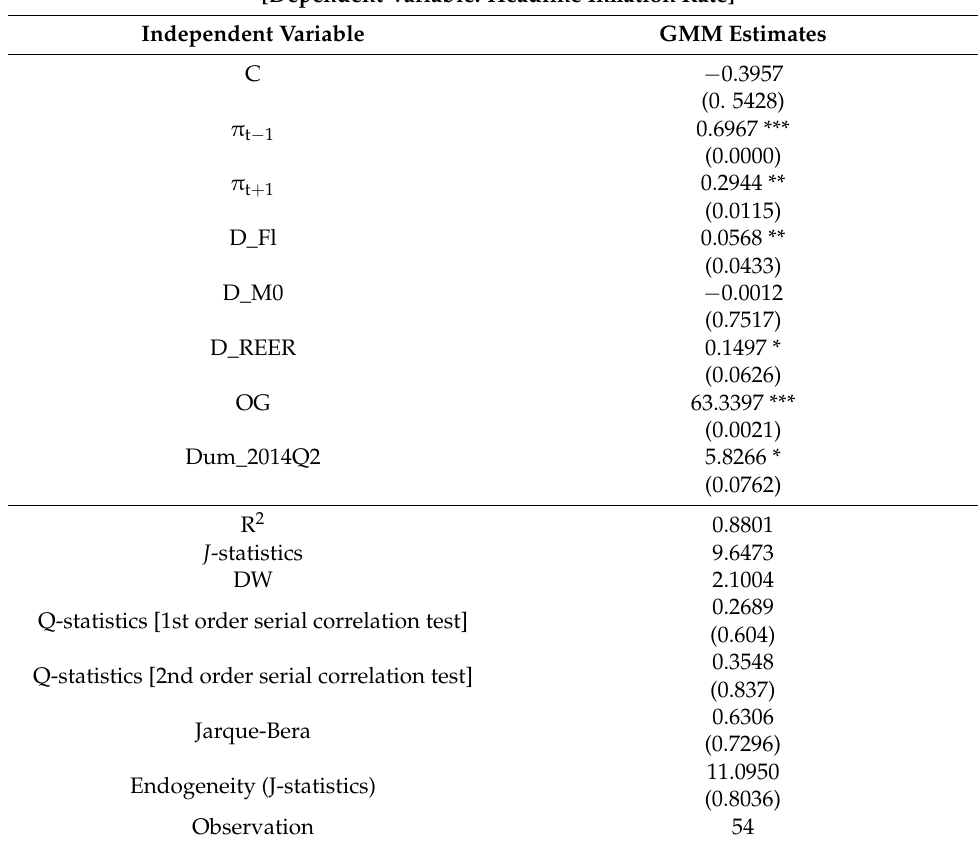
Table 5. GMM estimates of the